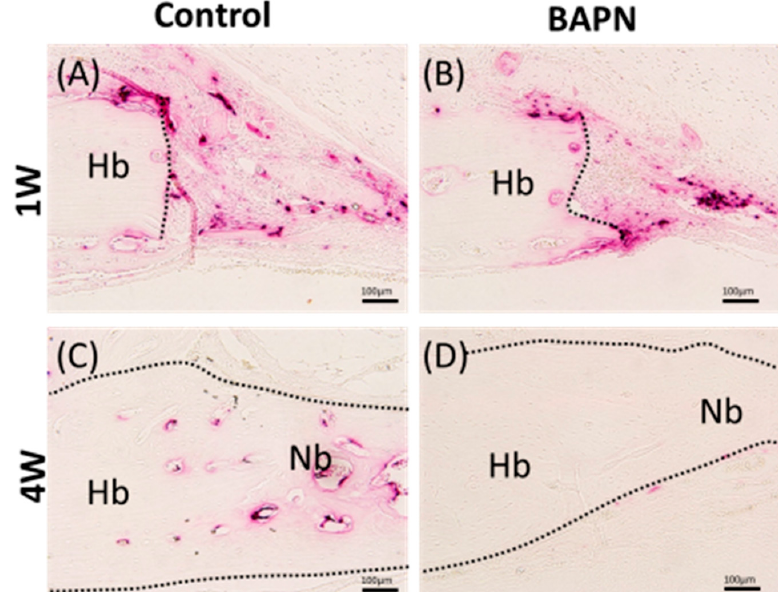
Figure 8. Osteoclast activity represented by TRAP staining at the cut surface of defects at Week 1 and Week 4. ( A ) Control at Week 1; ( B ) BAPN at Week 1; ( C ) Control at Week 4; ( D ) BAPN at Week 4. Osteoclastic activity disappeared in the BAPN group at Week 4. Magnification, ×20.